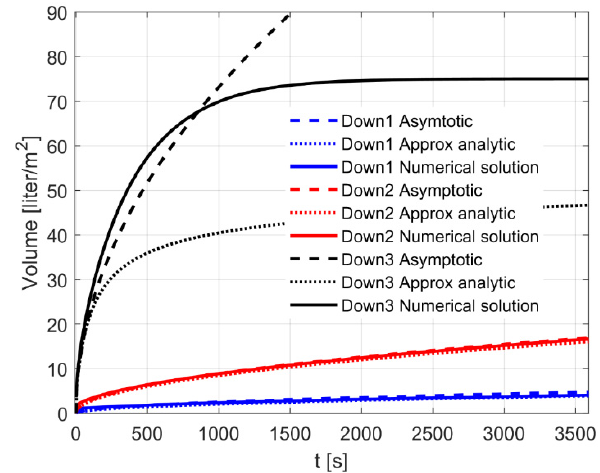
Figure 5. Water volume [L] captured per square meter with the Down-flow SPB storage studied as a function of time [s]. Blue curves: Down1, red curves: Down2, and black curves: Down3. Solid line: the numerical model, dotted line: analytical solution, and dashed line: asymptotic solution.